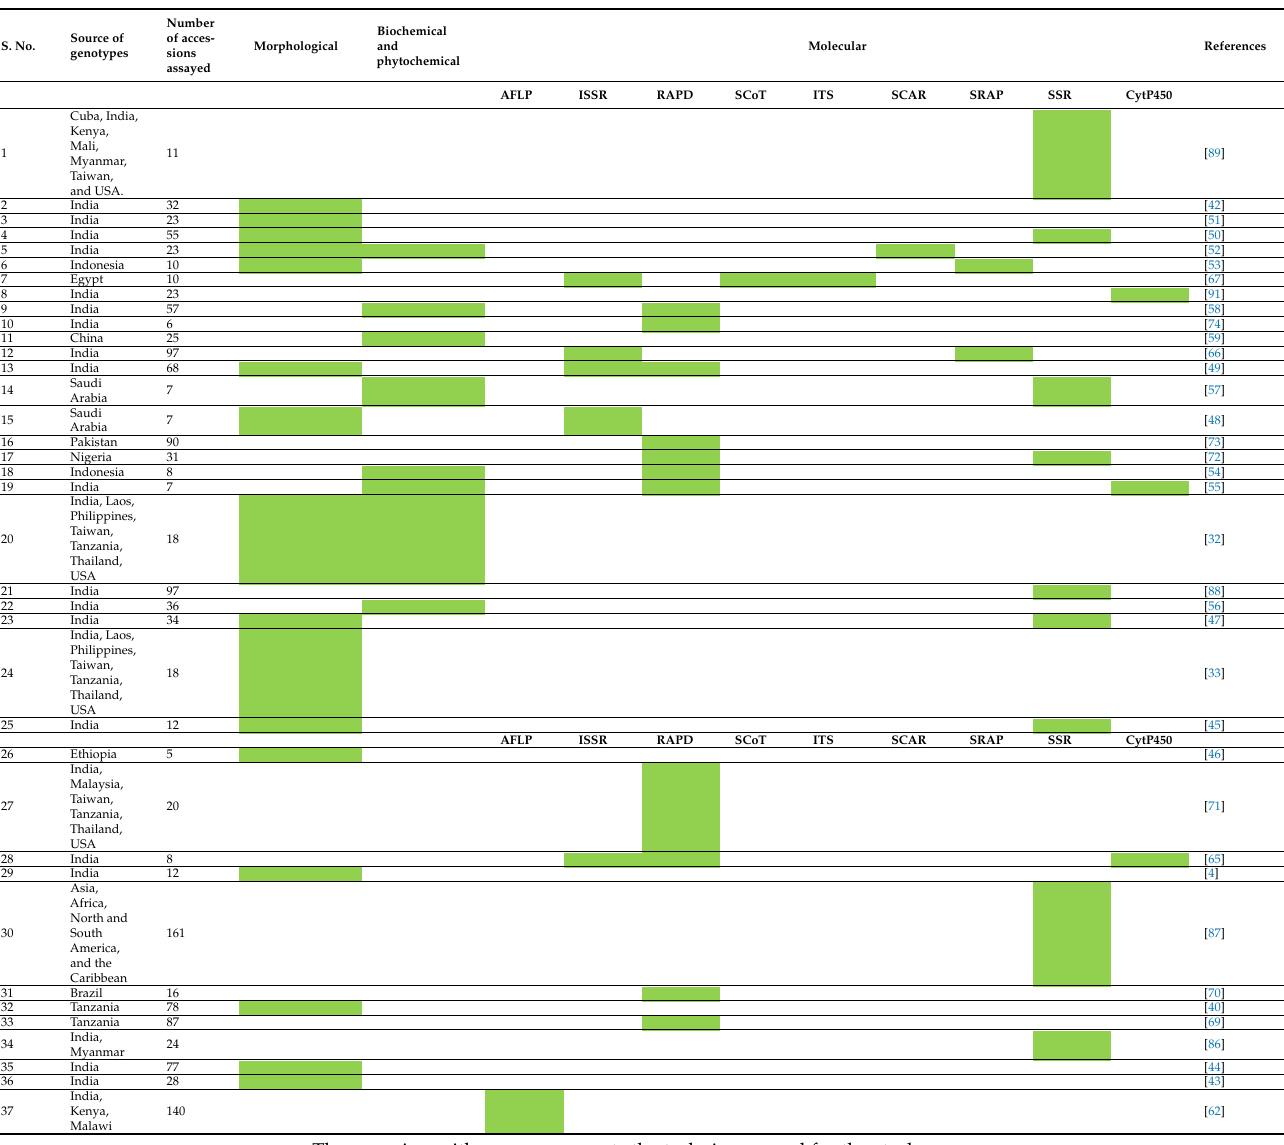
The mapping with green represents the techniques used for the